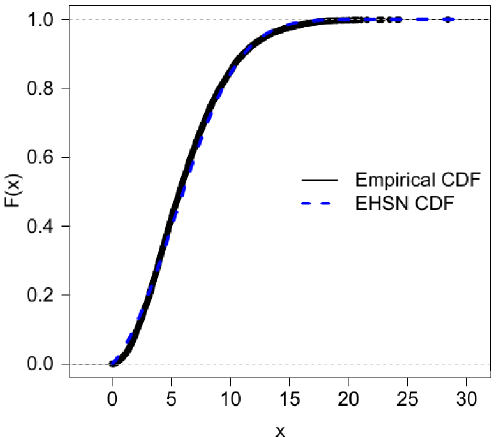
Figure 5. Empirical and fitted EHSN cdf for Speed of Wind in dataset 1.